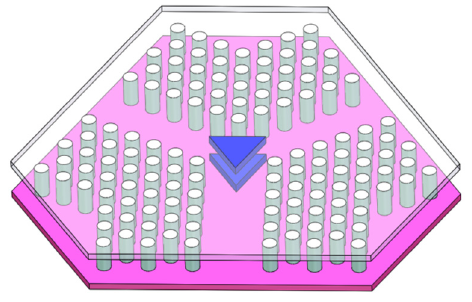
Figure 2. Design of the Y-typed microwave photonic circulator with two triangular ferrites.